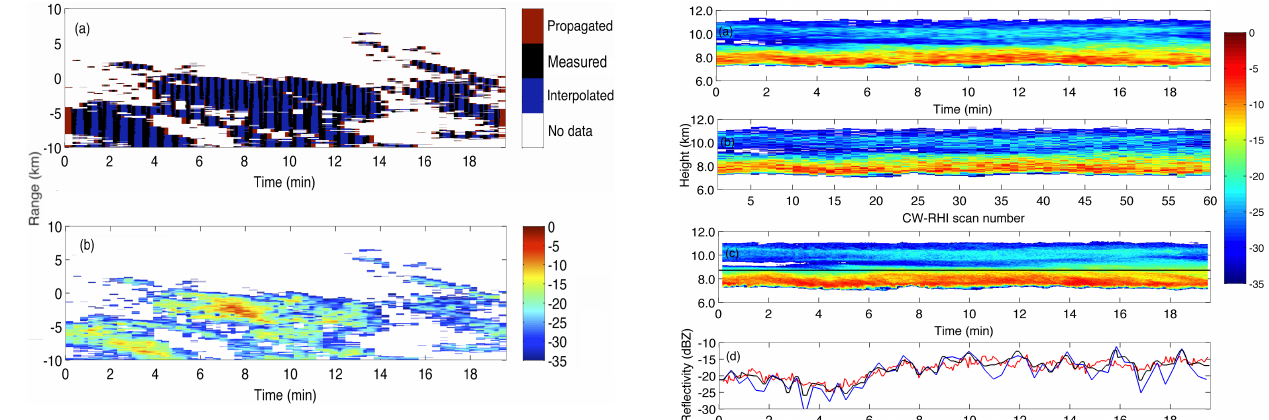
Fig. 7. Ground-parallel cross section (constant height) and x axis along the scanning direction of a cirrus cloud observed at the SGP: (a) the cloud mask of the 3-D gridded data, and (b) the 3-D gridded Ka-SACR radar reflectivity field.